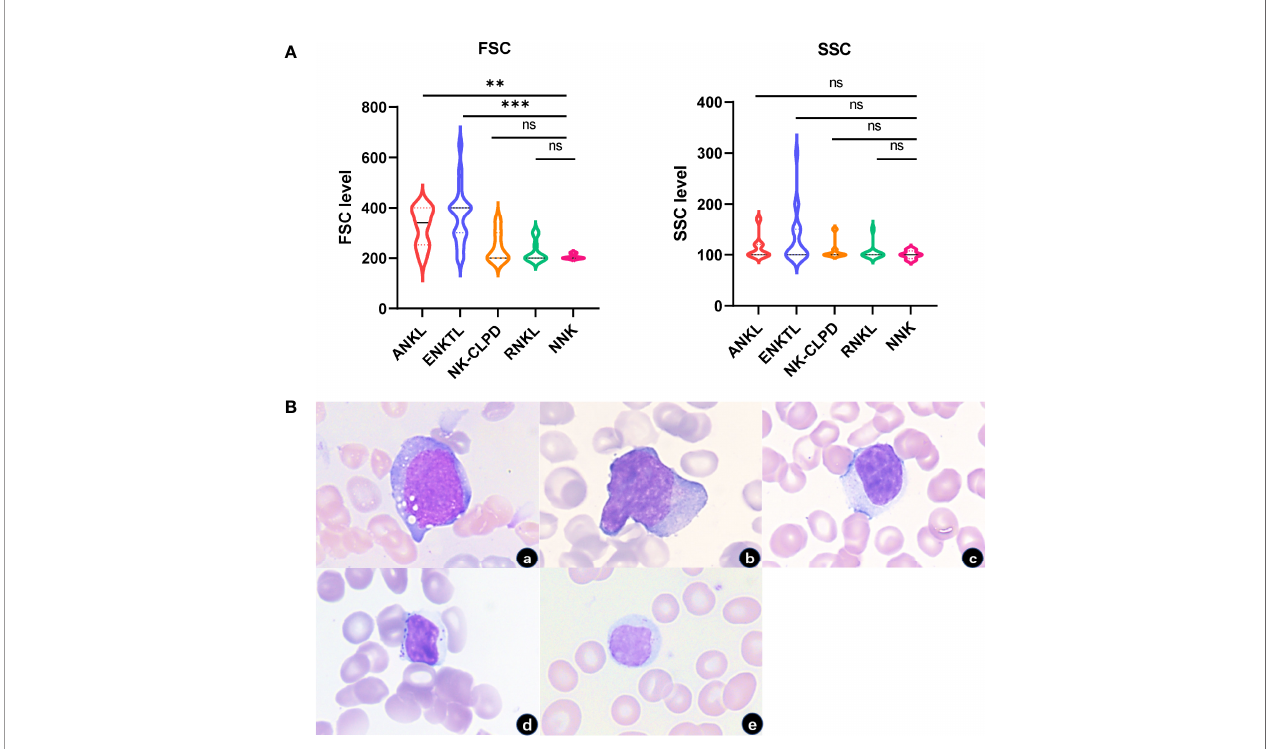
FIGURE 2 | FSC and SSC characteristics of NK cells in each group. (A) FSC of tumor cells in ANKL and ENKTL were signi fi cantly higher than those of normal NK cells and reactive NK cells. There was no signi fi cant difference in SSC between the NK cells of each group. (B) Morphologically tumorigenic NK cells in ANKL and ENKTL were signi fi cantly larger with or without granules in the cytoplasm (a, ANKL; b, ENKTL; c, NK-CLPD; d, RNKL; e, NNK; 1000×) (**p<0.01, ***p<0.001). ns, no signi fi cant